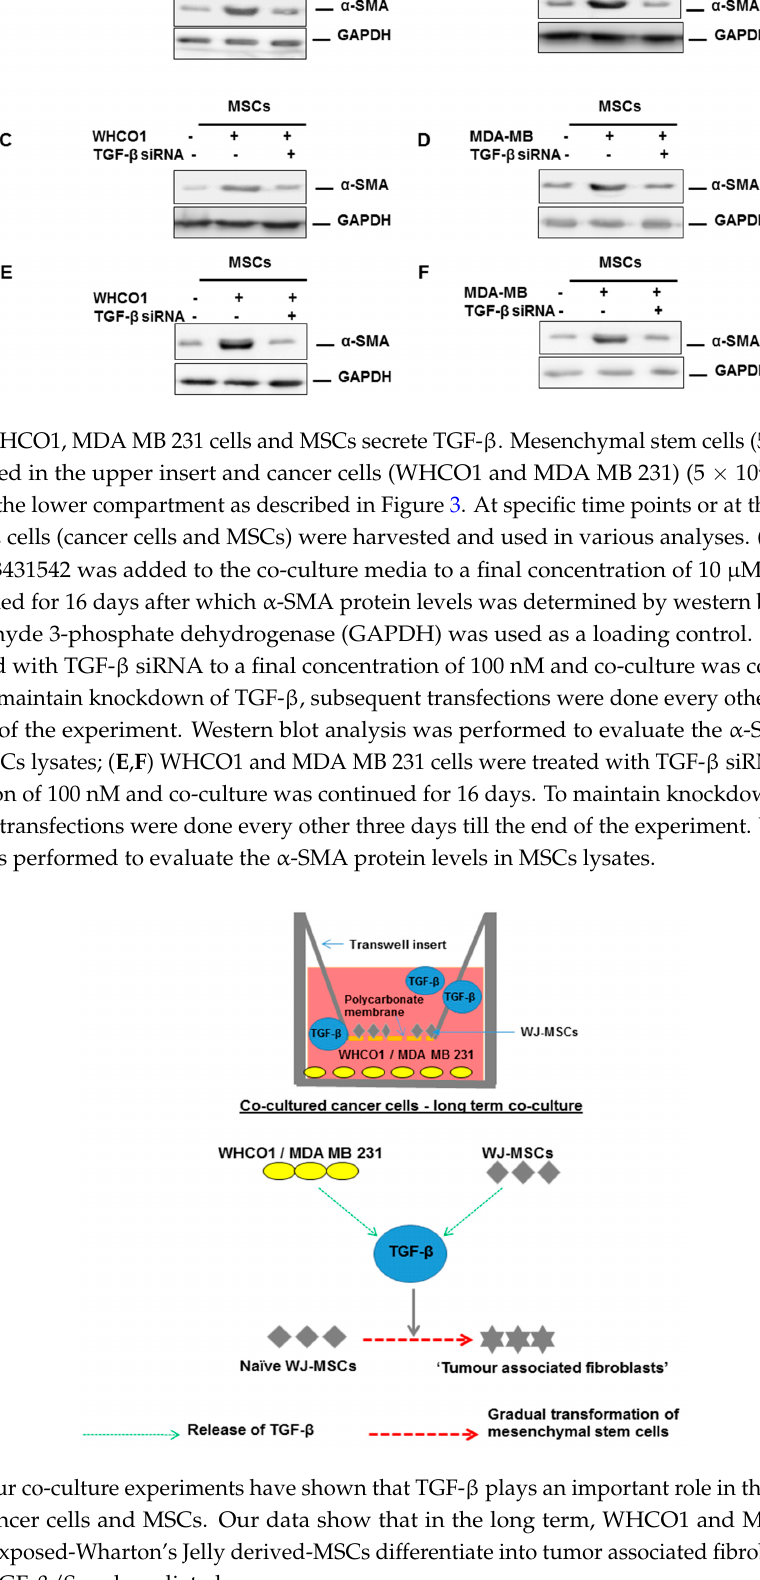
Figure 5. Our co-culture experiments have shown that TGF- β plays an important role in the interaction between cancer cells and MSCs. Our data show that in the long term, WHCO1 and MDA MB 231 cancer cell exposed-Wharton’s Jelly derived-MSCs differentiate into tumor associated fibroblasts (TAFs) through a TGF- β /Smad-mediated process.